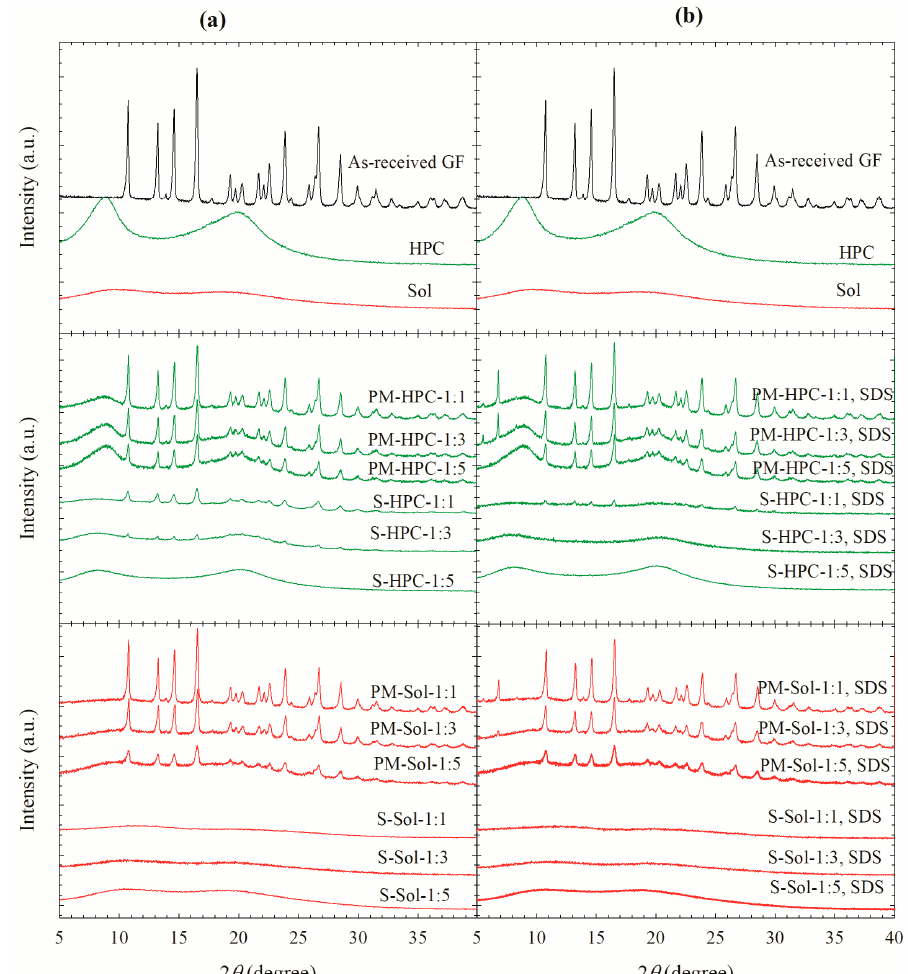
Figure 2. X-ray diffractograms of as-received GF, HPC, Sol, physical mixtures (PMs) of GF–HPC/Sol and the spray-dried powders prepared using the GF solutions with 1:1, 1:3, and 1:5 drug:polymer mass ratios: ( a ) without SDS and ( b ) with 0.125% SDS.